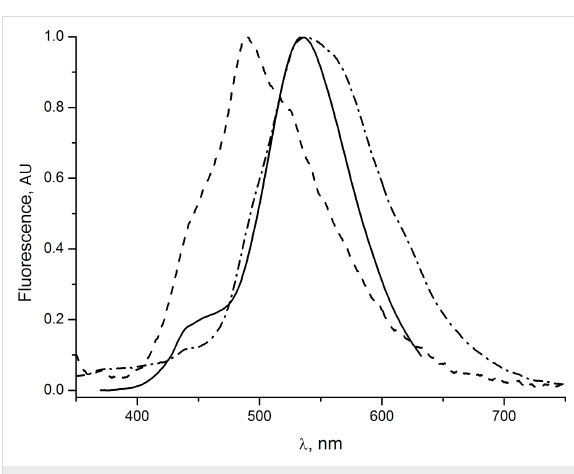
Table 2: Solvent-dependent optical properties of the dye 4 .